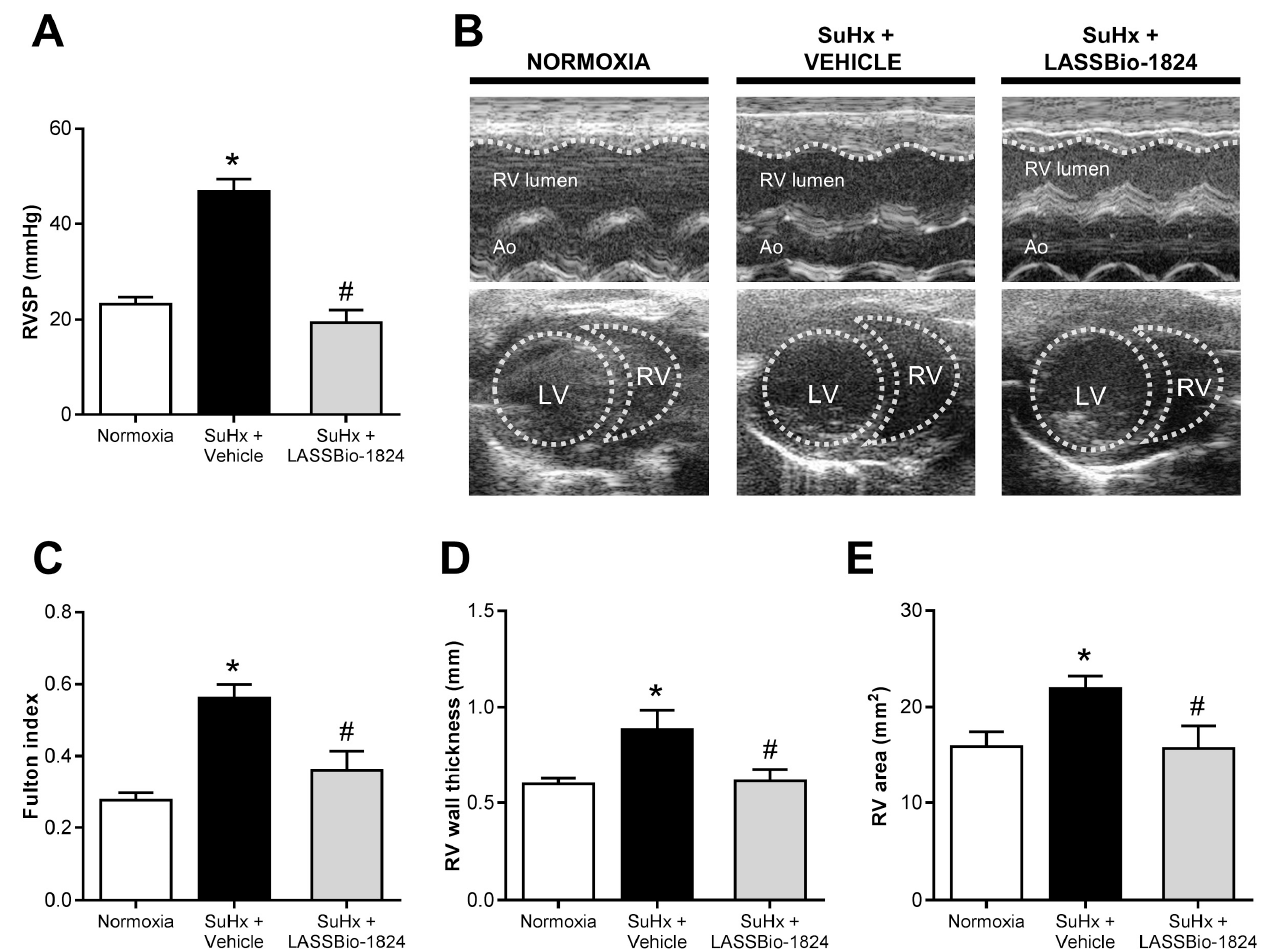
Figure 3. Effect of LASSBio-1824 on right-ventricle remodeling and hemodynamics in SuHx. ( A ) RV systolic pressures after treatment ( n = 5 rats per group). ( B ) Representative images of cardiac structure by TTE. Traced lines depict ventricular endocardial surfaces. ( C ) Fulton index of hypertrophy of RV ( n = 5 rats per group). ( D ) Echocardiographic measurement of RV wall hypertrophy ( n = 5 rats per group). ( E ) Echocardiographic measurement of RV end-diastolic area ( n = 5 rats per group). Ao, aorta; LV, left ventricle; RV, right ventricle; RVSP, right-ventricle systolic pressure; TTE, transthoracic echocardiography. * p < 0.05 compared to normoxia. # p < 0.05 compared to SuHx + Vehicle. Table 3. Cardiac function and ventricular hemodynamic measurements.